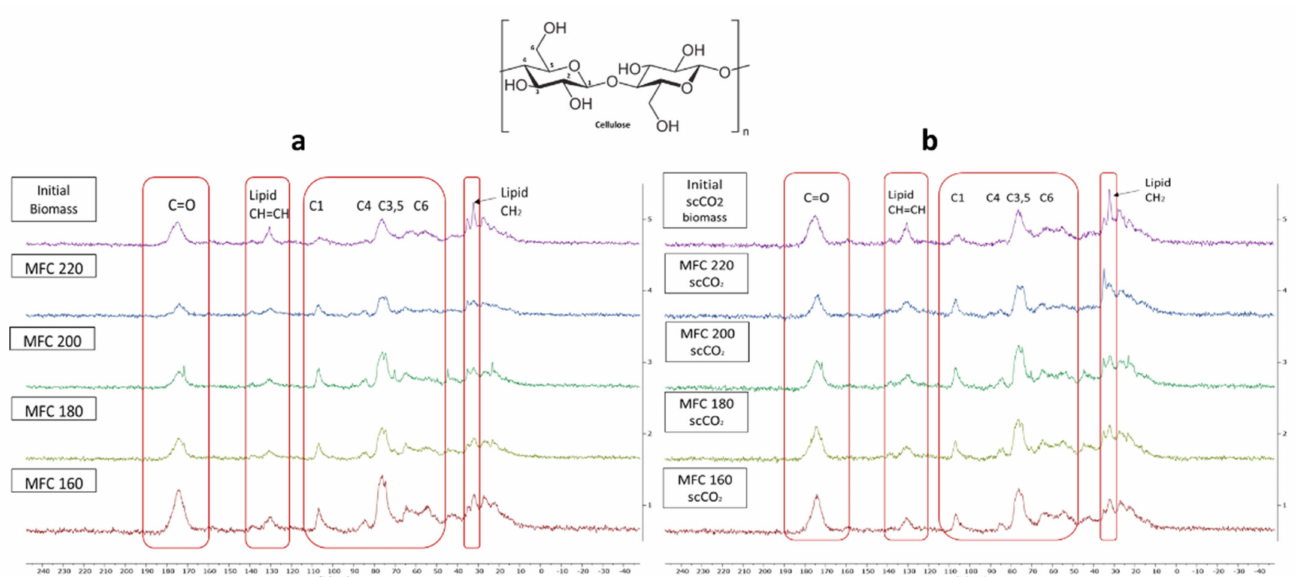
Figure 8. Solid state 13 C CPMAS NMR spectra of ( a ) standard method MFC and ( b ) scCO 2 method MFC. NB. ‘Standard’ refers to without any scCO 2 pretreatment.